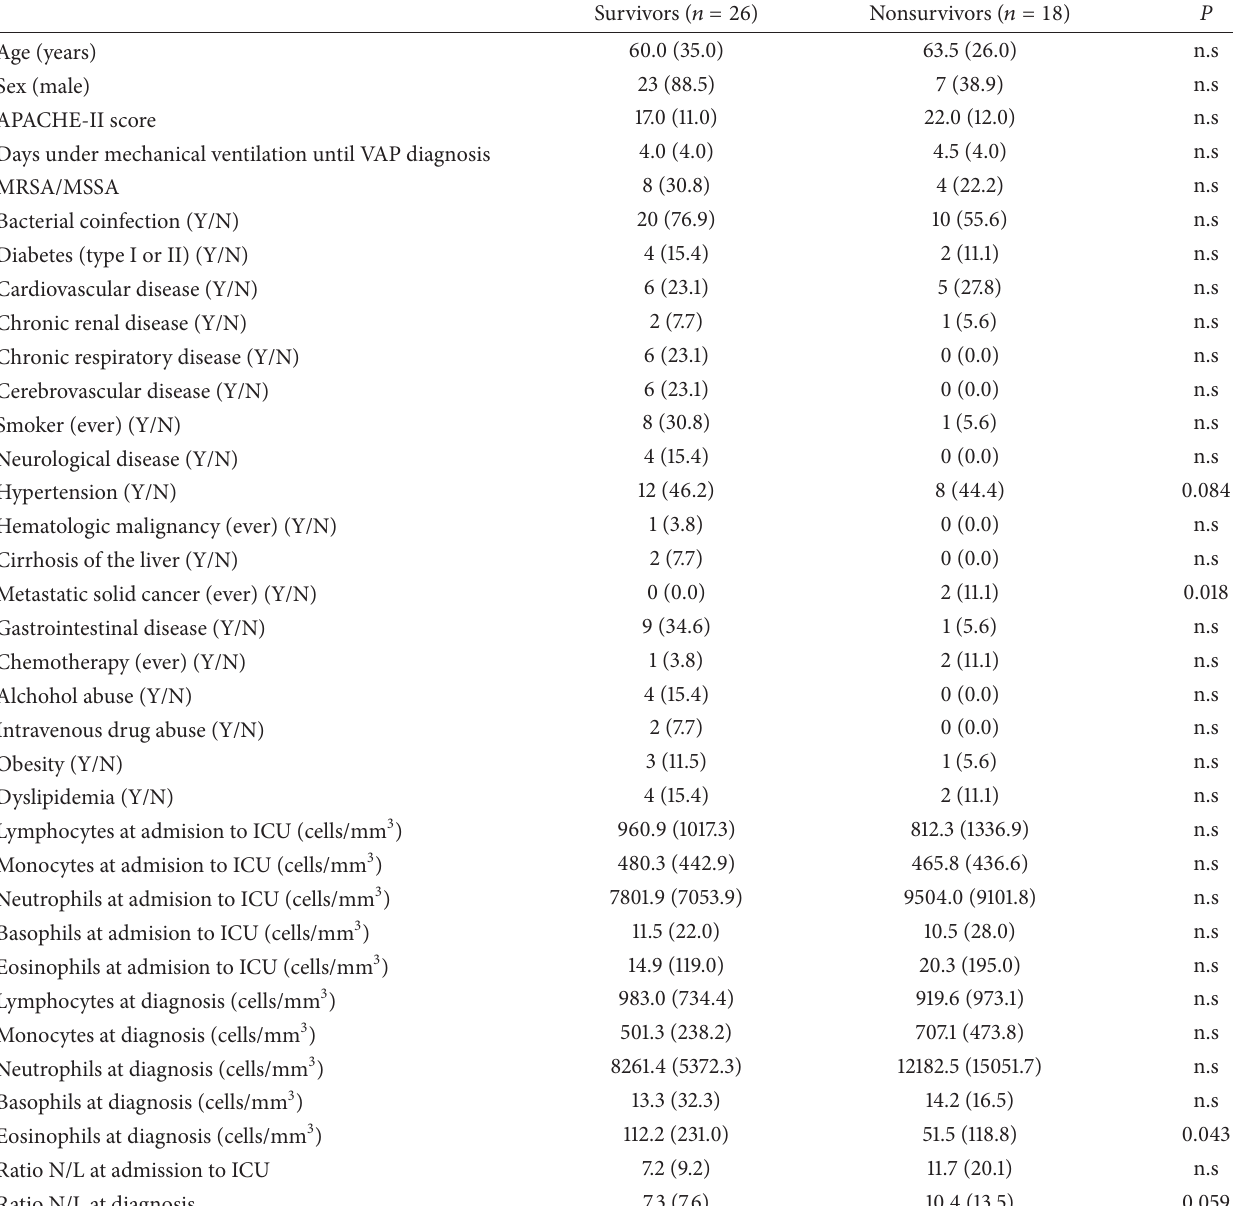
Table 1: Clinical characteristics of survivors and